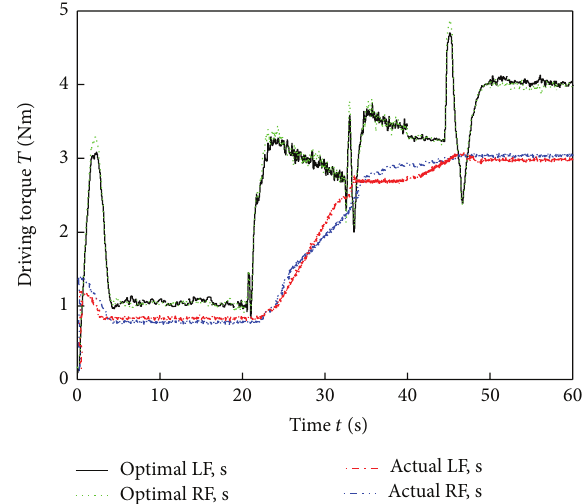
Figure 13: Front-wheels driving torque comparison of different control strategy.